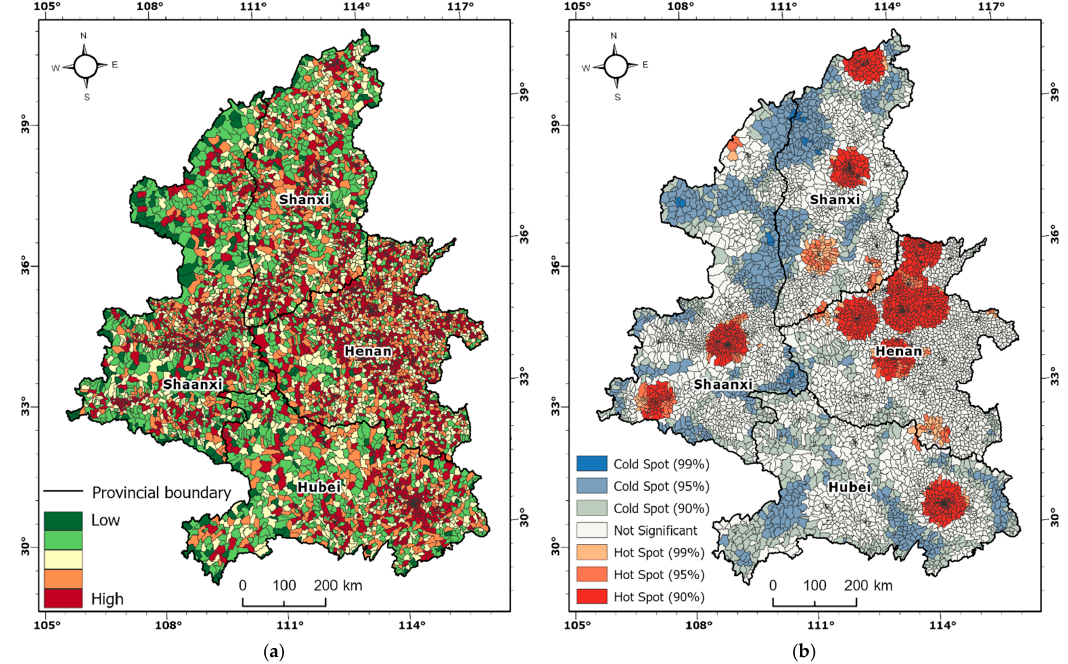
Figure 8. Characteristics of township hub level: ( a ) Spatial distribution of township hub level; ( b ) Spatial autocorrelation of township hub level.